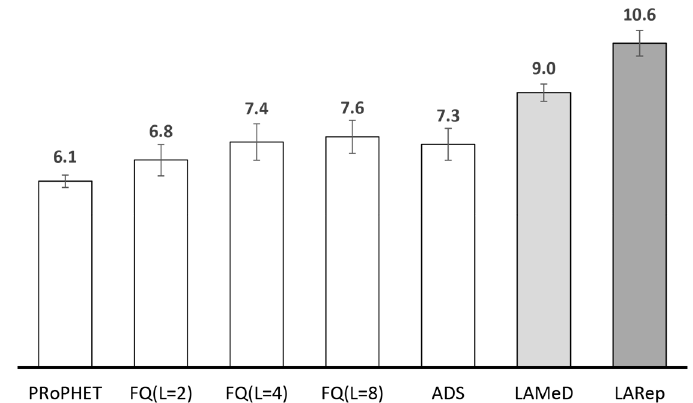
Figure 17. Throughput (in %) in the Skudai scenario.